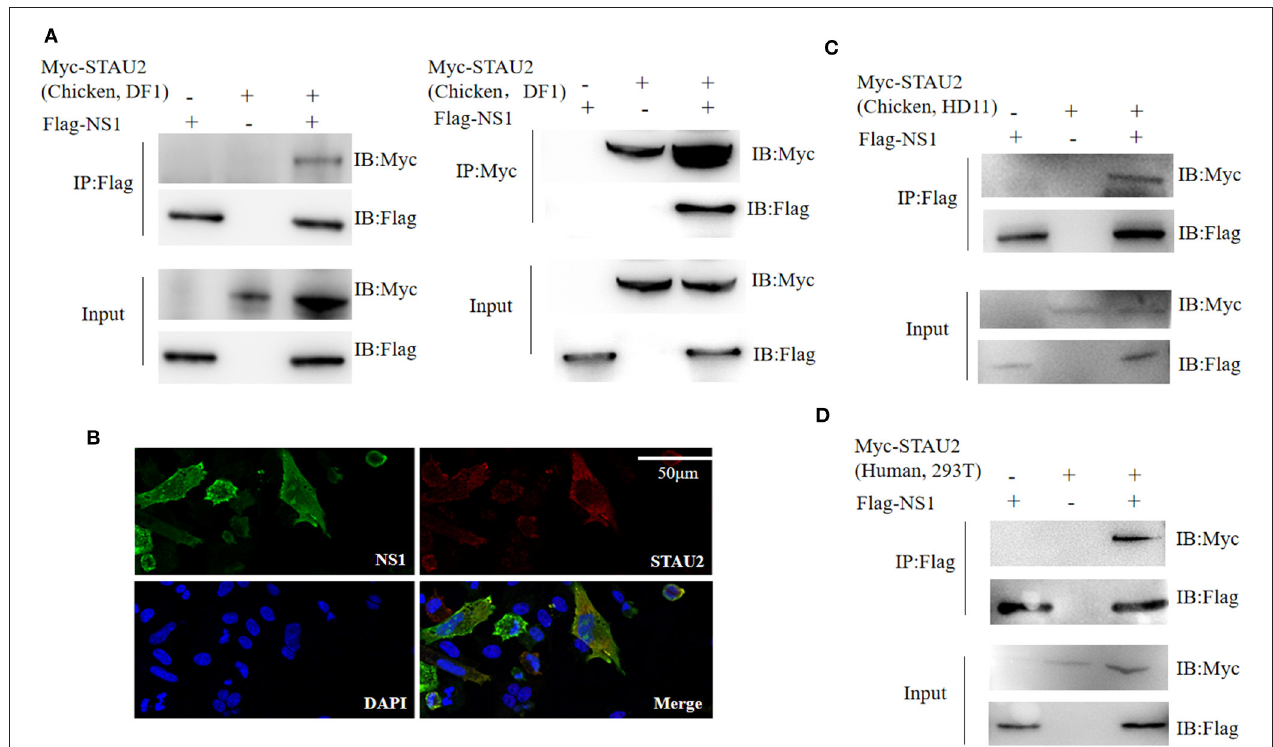
FIGURE 4 | Interaction of Staufen double-stranded RNA-binding protein 2 (STAU2) with non-structural protein 1 (NS1). (A) Chicken DF1 cells were transfected with the indicated plasmids. An immunoprecipitation was carried out to detect the interaction between STAU2 and NS1 using anti-FLAG or anti-Myc antibodies, followed by an immunoblot analysis with the indicated antibodies. (B) An immunofluorescence analysis of STAU2 and NS1. Chicken DF1 cells transfected with FLAG-tagged NS1 and Myc-tagged STAU2 were fixed and incubated with anti-FLAG and anti-Myc antibodies, followed by an incubation with the secondary antibody. The nuclei were stained with DAPI. The colocalization of NS1 and STAU2 was detected by confocal microscopy. (C,D) Confirmation of the STAU2–NS1 interaction in additional cell types. Chicken HD11 cells or human 293T cells were transfected with the indicated plasmids. An immunoprecipitation using anti-FLAG followed by an immunoblot analysis with the indicated antibodies was carried out to detect the interaction between STAU2 and